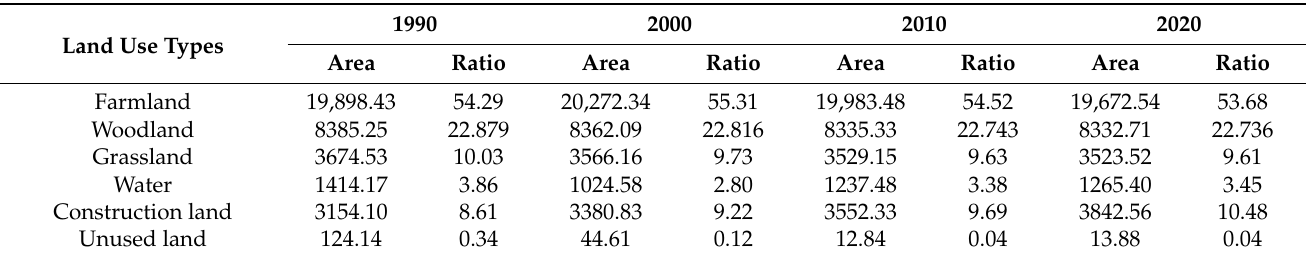
Table 2. Area (km 2 ) and ratio (%) of land use types in the Yellow River Basin (Henan section) from 1990 to 2020.